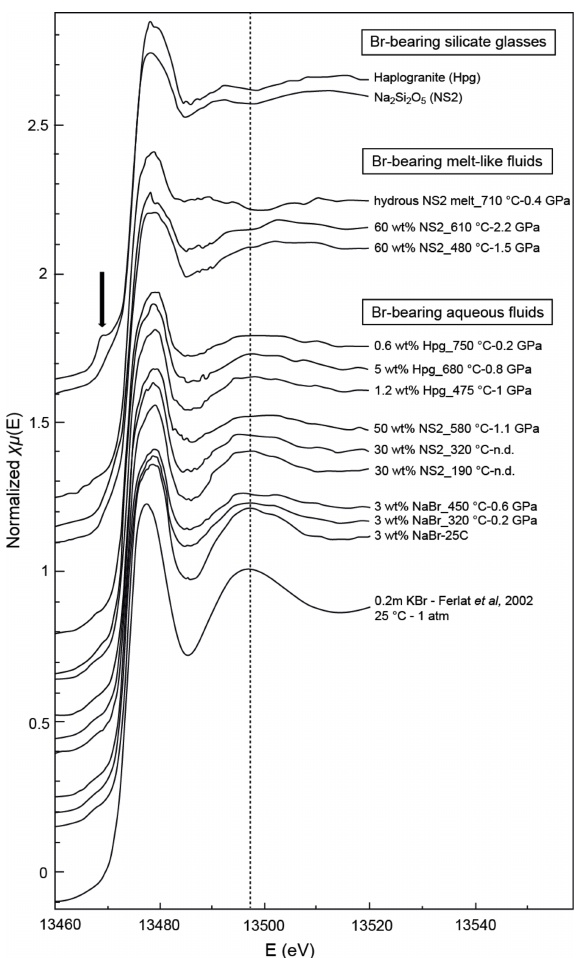
Figure 4. Normalized Br K-edge XANES spectra collected on Br- bearing silicate glasses, aqueous fluids, and hydrous silicate melts at various pressure and temperature conditions. Spectra are offset for clarity. The vertical dashed line is a visual guide to appreciate phase shifts. The black arrow shows the pre-edge feature in the hap- logranite glass spectrum corresponding to the 1s to 4p transition in Br (Burattini et al., 1991).